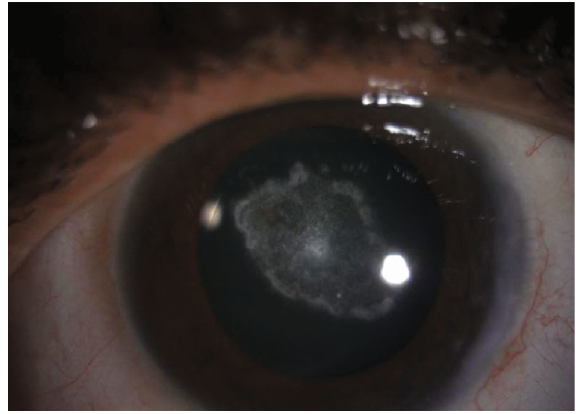
Figure 1: Preoperative anterior segment photo of the left eye.